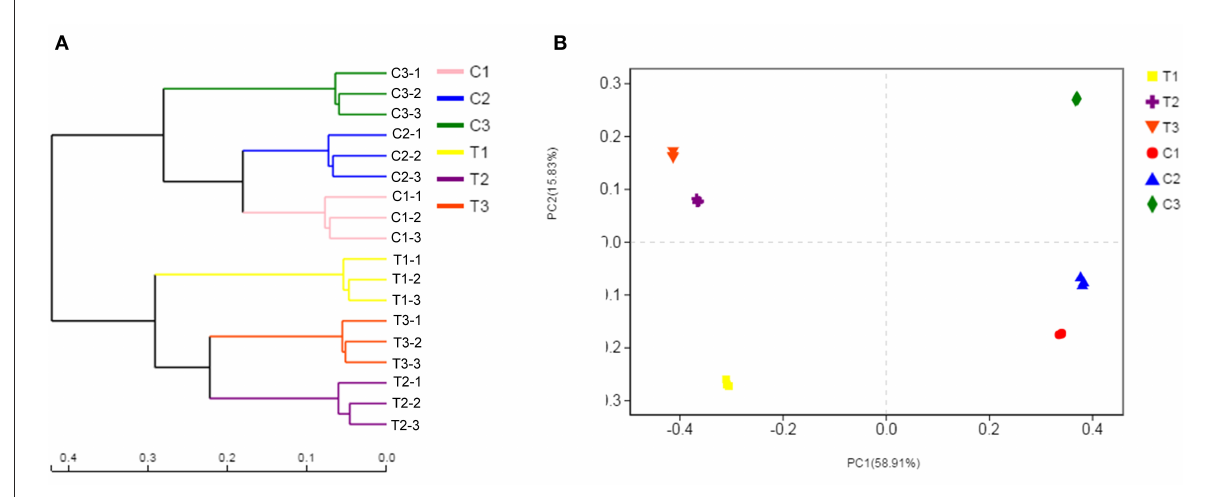
FIGURE8 Soil samples were separated by hierarchical clustering analysis and PCoA. The similarity and differences in the bacterial community structures were determined by hierarchical clustering tree analysis (A) . PCoA analysis of the bacterial communities at the OTU level (B) . All data in the experiment represent three independent